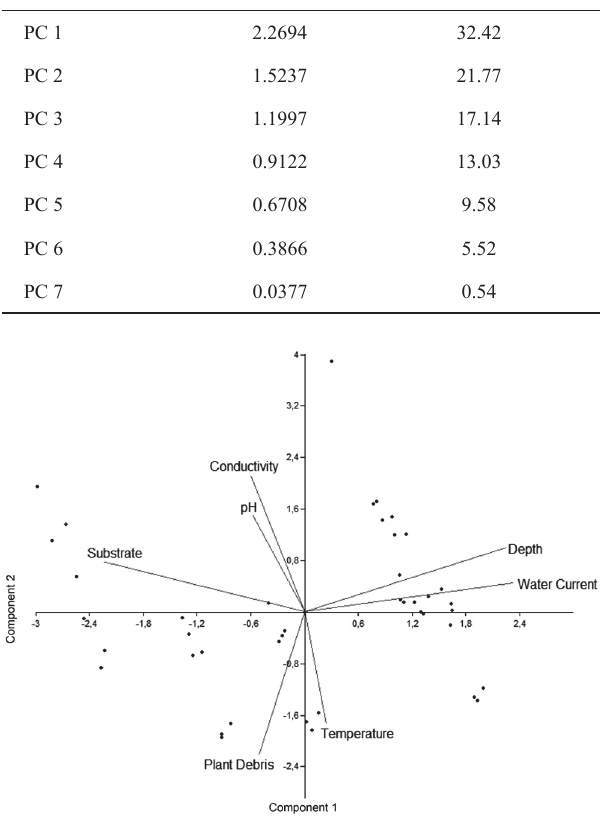
Fig. 5 . Biplot resulting from Principal Component Analysis with seven variables. Dark circles represent sampling units.